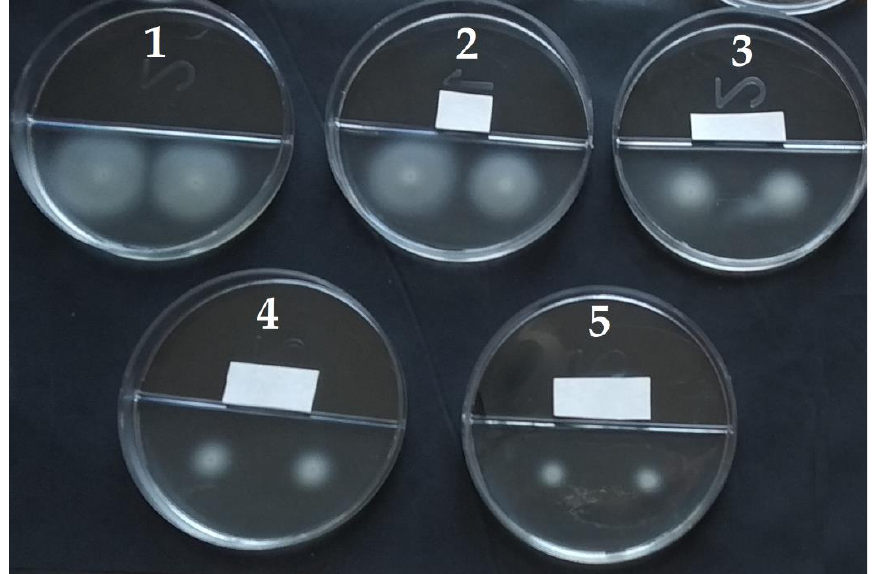
Figure 10. The action of 2-octanone on the swimming motility of A. tumefaciens C58 (1: control without VOC; 2: 12.9 g/m 3 ; 3: 25.81 g/m 3 ; 4: 38.71 g/m 3 ; 5: 64.52 g/m 3 ). Photo of a representative ex-